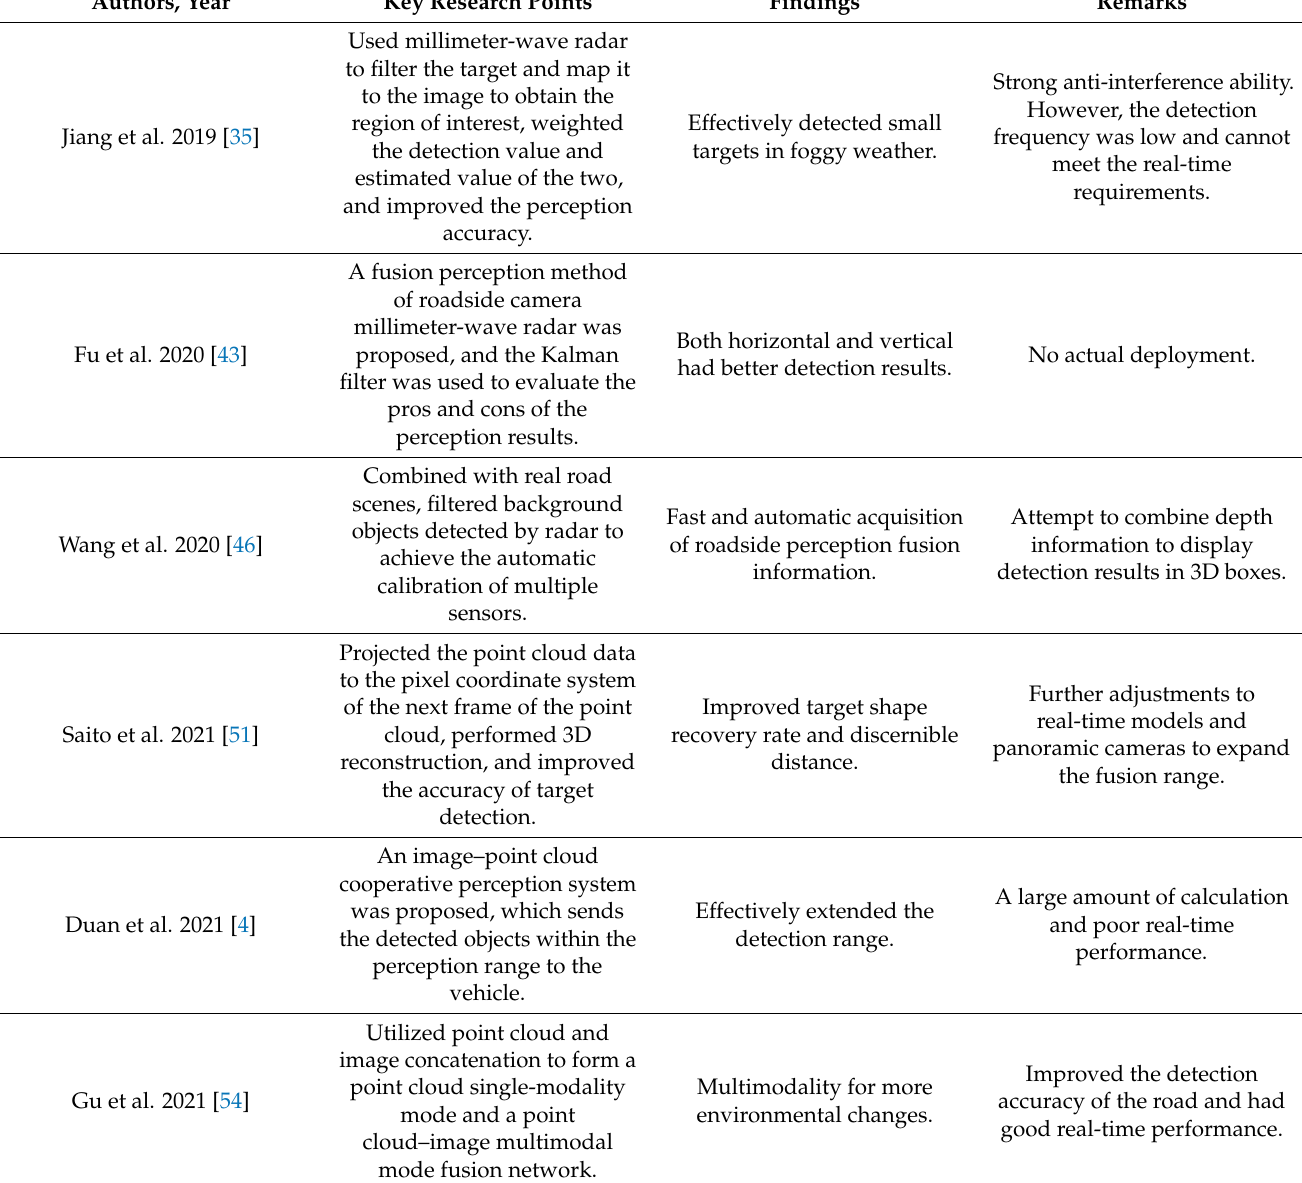
Table 4. Summary and classification of research on image–point cloud fusion